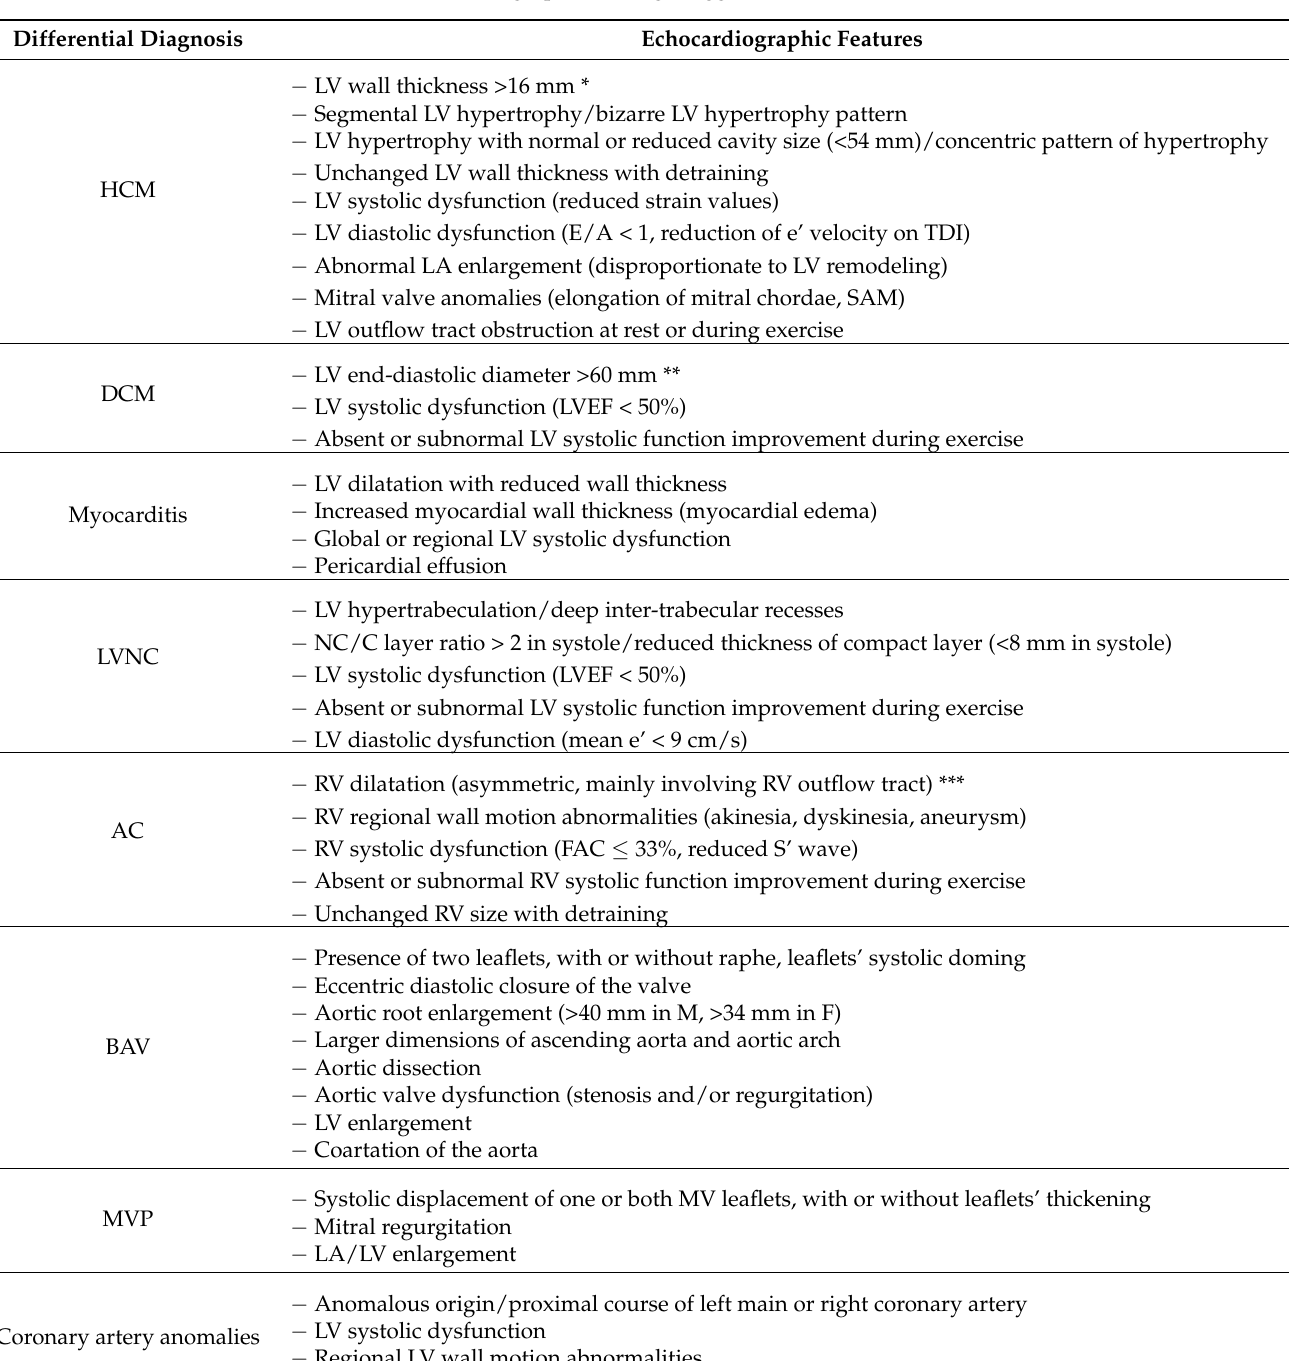
Table 2. Athlete’s echocardiographic findings suggestive of cardiovascular